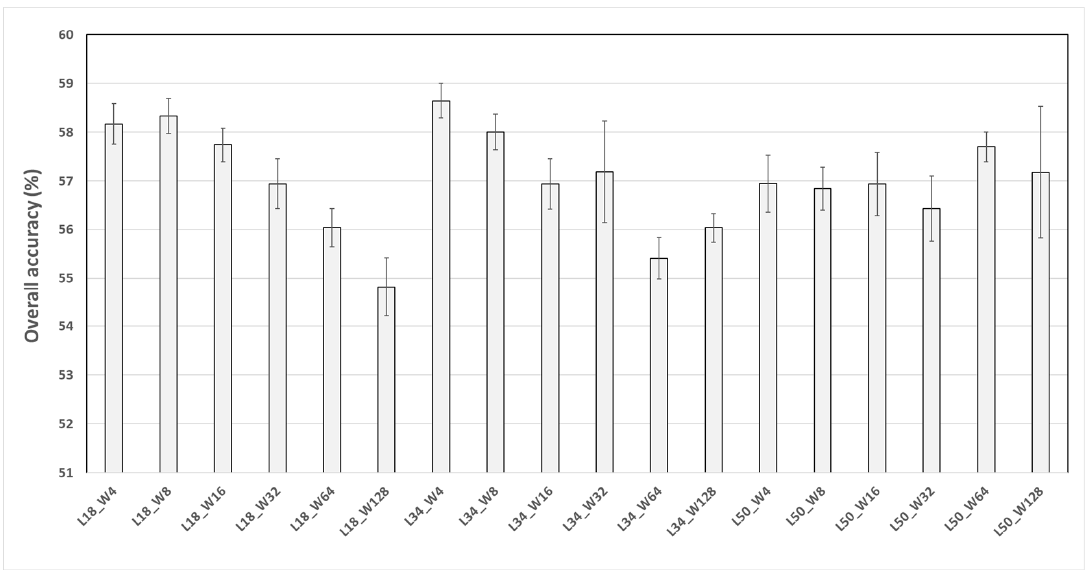
Figure 4. Overall accuracy results for ResNets with the ABMI_PP data source based on the spatial extension assessment and best-test training convergence. Configurations are designated as L for depth and W for input image size. For example, L18_W4 is an 18-layer ResNet with an input image size of 4 × 4 pixels.